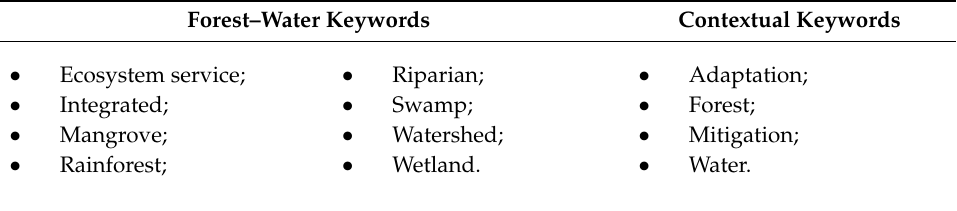
Table 1. List of keywords used in the (Intended) Nationally Determined Contributions ((I)NDCs)